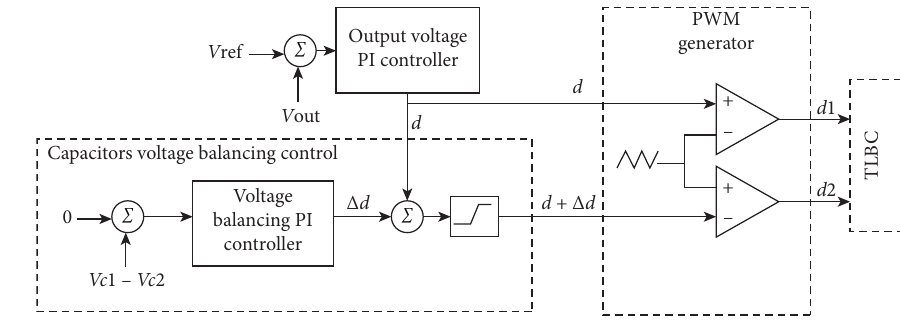
Figure 11: Block diagram of the global control scheme using PI controller. Table 5: PI controller parameters corresponding to the three subintervals.